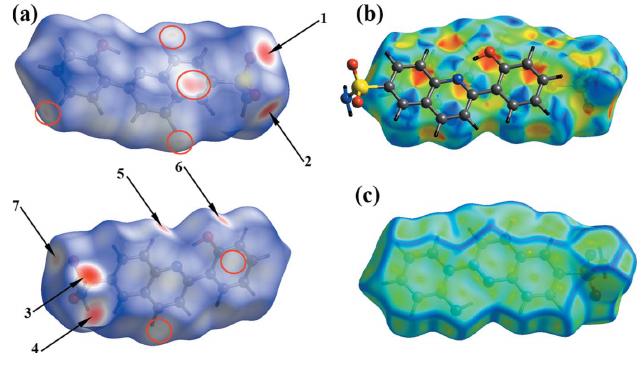
Figure 5 Aview of the Hirshfeld surface for (I) mapped over ( a ) d norm in the range (cid:4) 0.5231 to +1.1263 arbitrary units, ( b ) shape-index and ( c ) curvedness.